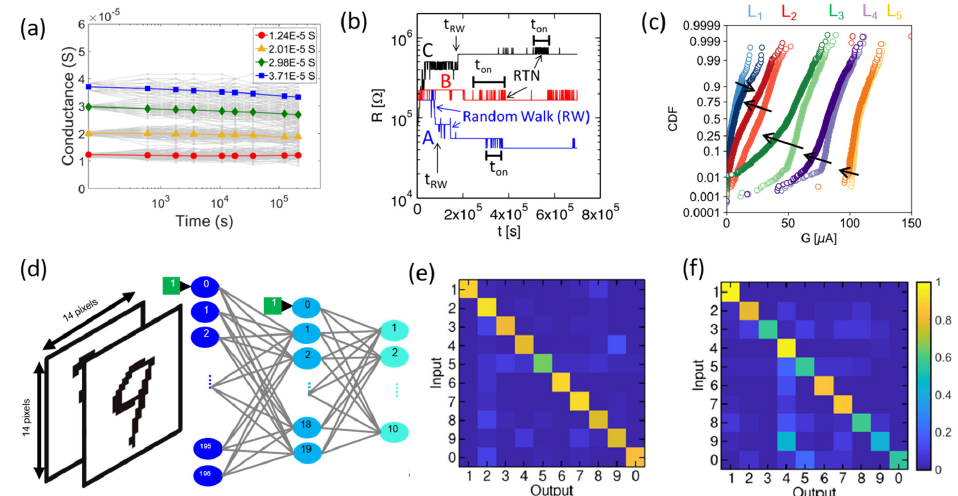
Figure 7. Drift and fluctuations in RRAM devices. ( a ) Conductance as function of time for 4 different analog levels after heating at 150 °C. ( b ) Different fluctuations’ effect as a function of time. ( c ) Cumu- lative distributions of 5 programmed levels before and after annealing at T = 125 °C. ( d ) Conceptual schematic of the neural network used to evaluate the effect of drift and its accuracy in classifying the MNIST dataset before ( e ) and after ( f ) annealing. Adapted from [43,58,59].